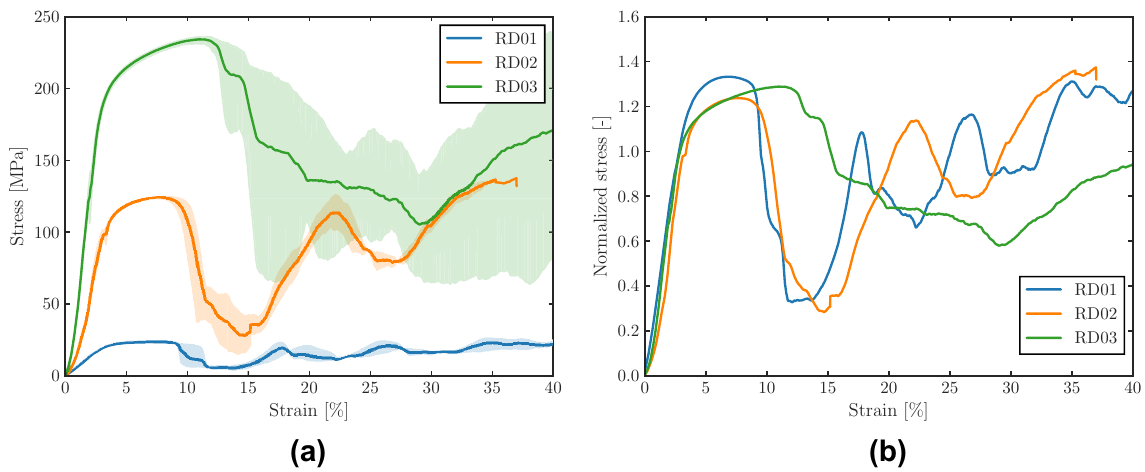
Figure 4. Stress strain curves of FCCm structures with different relative densities for ( a ) macroscopic stress and ( b ) normalized macroscopic